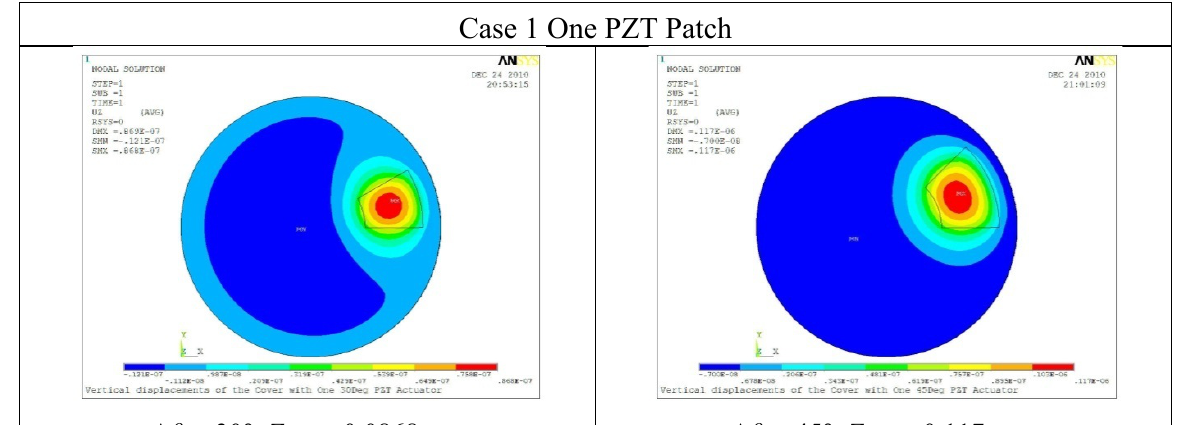
Table 5. Contour Plots of Displacement Generated by Active PZT Patches on